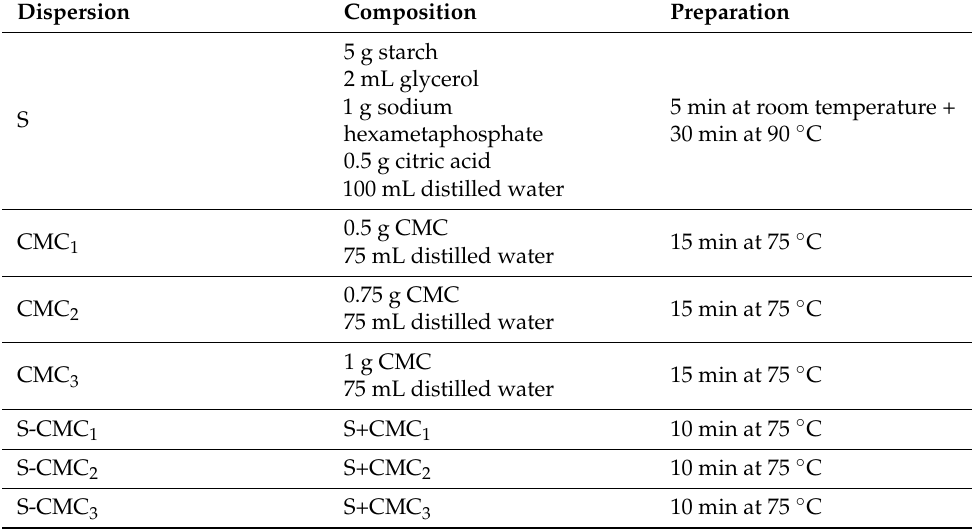
Table 1. Composition and preparation method of